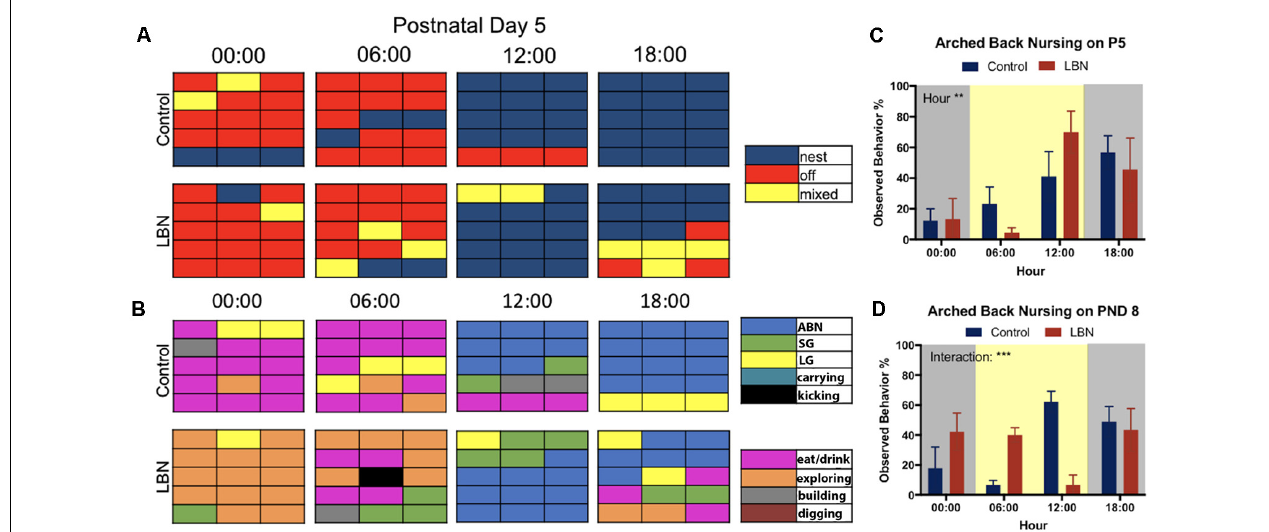
FIGURE 3 | Comparison of current findings with previously used hand scoring approaches. (A) Representative graphs depicting the mean behavior expressed by each group during each epoch sampled. At postnatal day 5 (P5), control and LBN dams spent similar time on nest at 0:00, 6:00 and 12:00, with control dams having spent more time on nest that LBN mice at 18:00. (B) At hour 00:00 on postnatal day 5, control dams spent more time off nest and eating while LBN dams explored. At 06:00, LBN dams present more eating/drinking behavior than controls and a subset exhibited kicking behavior. At 12:00, all dams shifted behavior to arched-back nursing (ABN). At 18:00, control dams actively nursed while LBN dams engaged in mixed behavior. (C) Quantification of ABN demonstrated a significant effect of hour ( F ( 3,30 ) = 5.656, p = 0.003) but no condition or condition × hour interaction at P5. (D) At P8, a significant hour by condition interaction ( F ( 3,30 ) = 7.81, p = 0.0005) was found with LBN dams having engaged in more ABN during the transition from dark to light (6:00) and control dams engaged in more ABN than LBN dams at midday (12:00).